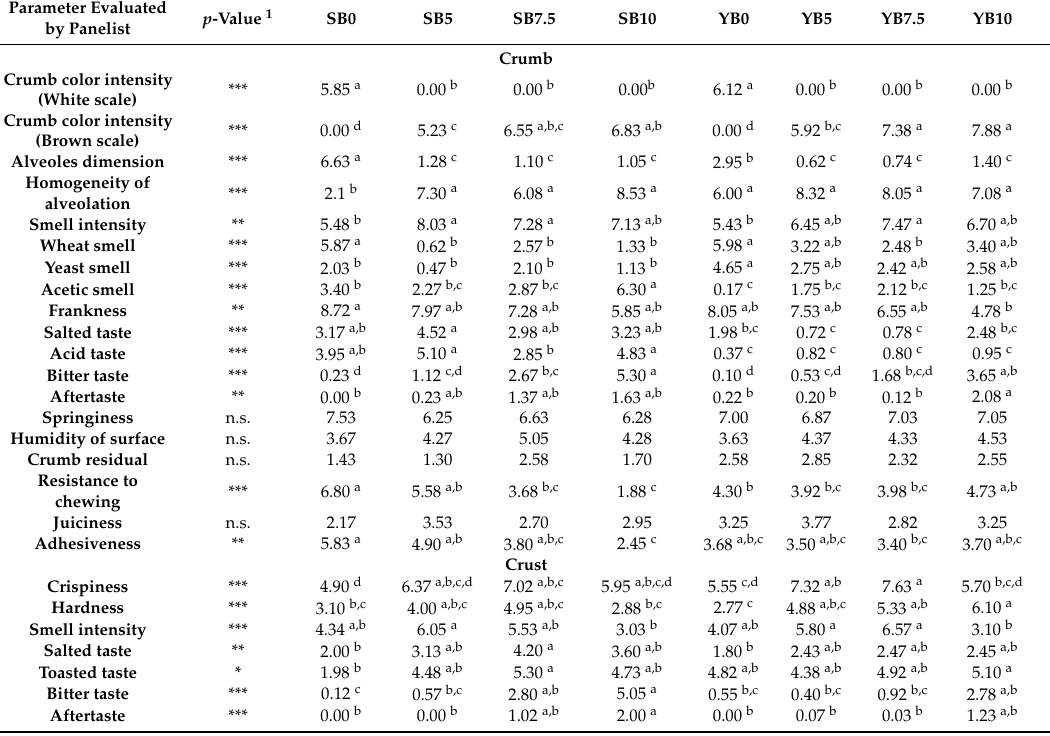
Table 8. Sensorial expression of cooked breads evaluated by panelists during tasting